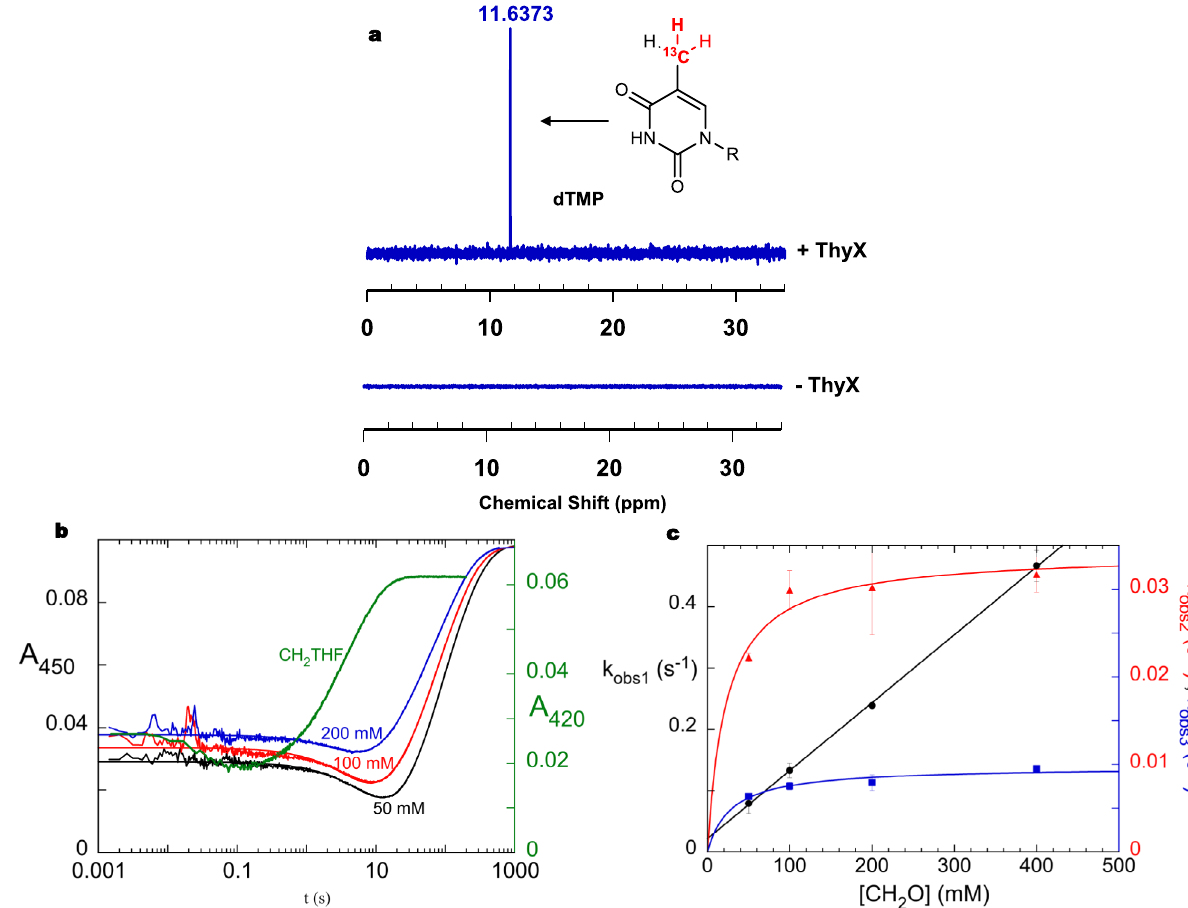
Fig. 2 Use of formaldehyde as a direct methylene donor in the T. maritima ThyX-catalyzed dUMP methylation. a 13 C-NMR spectrum of dTMP formed by ThyX in the presence of NADPH, dUMP, and 13 C-labeled CH 2 O (top). At the bottom is shown the 13 C-NMR spectrum of the control experiment conducted in the presence of NADPH, dUMP, and 13 C-labeled CH 2 O without adding ThyX. b Reaction of ThyX with formaldehyde. The reaction kinetics were investigated at different formaldehyde concentrations in stopped- fl ow experiments. The reduced enzyme-dUMP (FADH − • dUMP) complex was loaded into a stopped- fl ow instrument and mixed rapidly with solutions containing high concentrations of formaldehyde. Three examples of absorbance traces are shown using a logarithmic timescale. Traces were fi t to a sum of three exponentials. For comparison, the kinetic in the presence of the physiological methylene donor, CH 2 THF, is shown in green. c The observed rate constants of each phase varied with formaldehyde concentration. The observed rate constant ( k obs ) of the fastest phase (black), describing the decrease in absorbance at 450nm, increased linearly with formaldehyde concentration, consistent with a reversible bimolecular reaction of enzyme and formaldehyde: 1.11 ±0.01 M − 1 s − 1 , 0.022± 0.003s − 1 , giving a K D of 20± 3 mM. The k obs values for the two subsequent phases (red and blue data points) increased hyperbolically with formaldehyde concentration: maximum k obs2 of 0.034± 0.001s − 1 , K D of 23±8 mM and maximum k obs3 of 0.0097 ±0.0006 s − 1 , K D of 29± 10mM. The error bars are the standard deviation calculated from three independent